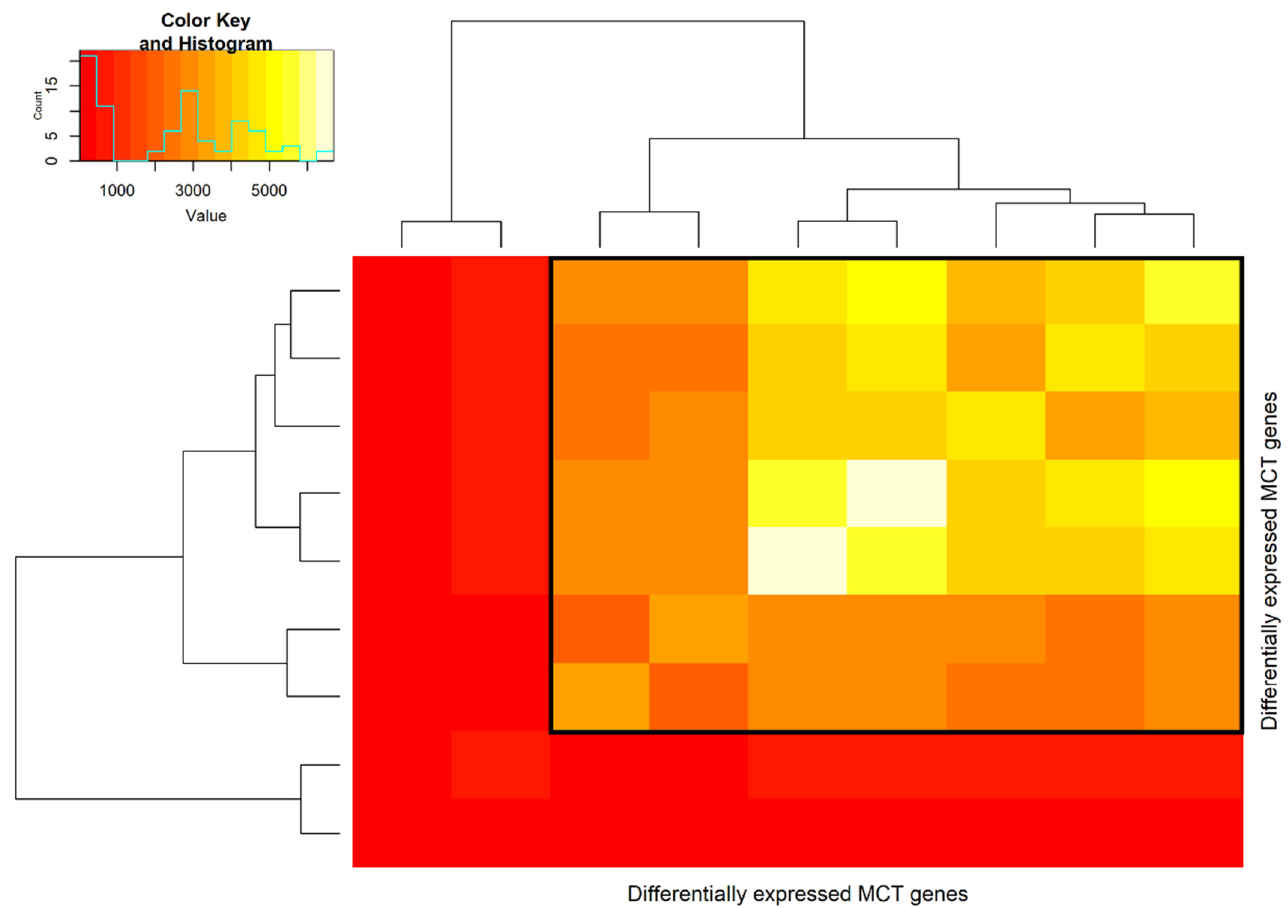
Figure 3. Hypernetwork heatmap of MCT transcripts ( n = 9) in PDAC stroma and epithelium. Colour intensity represents the number of binary relationships with the rest of the transcriptome ( n = 13,815 total transcripts) shared between a pair of MCT transcripts. Two clusters were identified, with cluster 1 having seven MCTs, including SLC16A1-AS1 , SLC16A6 , SLC16A5 , SLC16A10 , SLC16A2 , SLC16A13 , and SLC16A7 (highlighted in black box), and cluster 2 having two MCTs, including SLC16A9 and SLC16A4 .